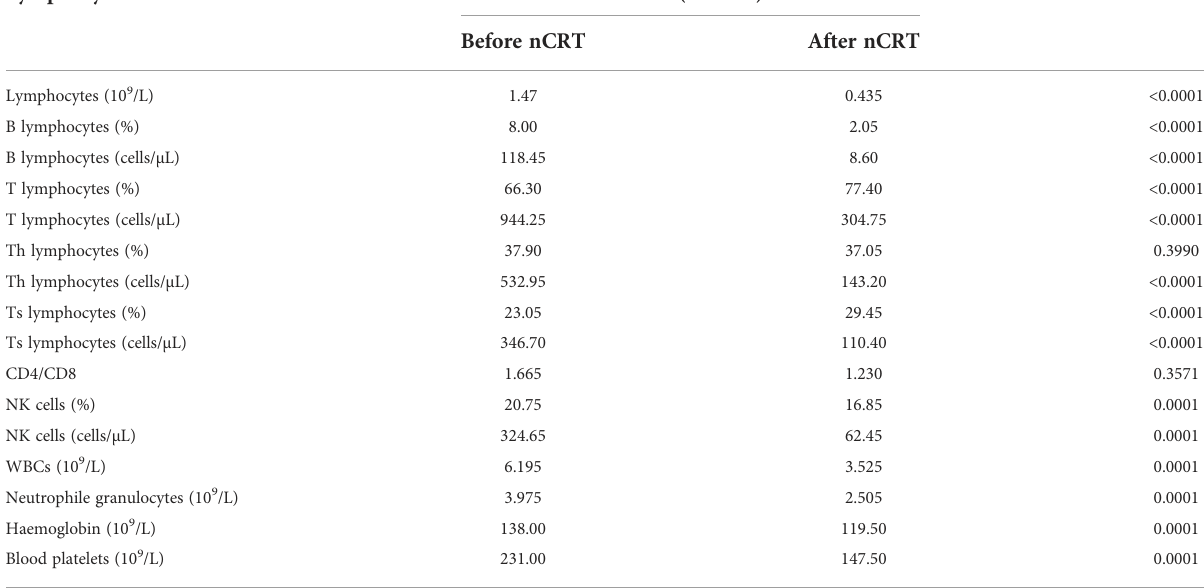
TABLE 3 Changes in the lymphocyte subset before and after